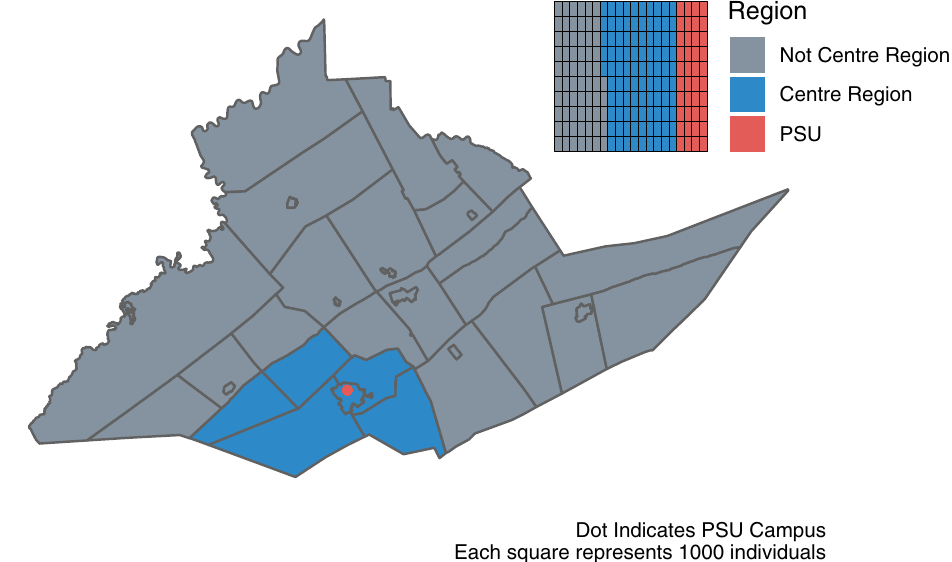
Figure 1. Map of Centre County, Pennsylvania, USA. Blue indicates the 5 townships and 1 borough that comprise the Centre Region. Red indicates the location of The Pennsylvania State University (PSU), University Park (UP) Campus. Inset illustrates the proportion of the county population in each region; PSU indicates the estimated student population that returned to campus for the Fall 2020 term.